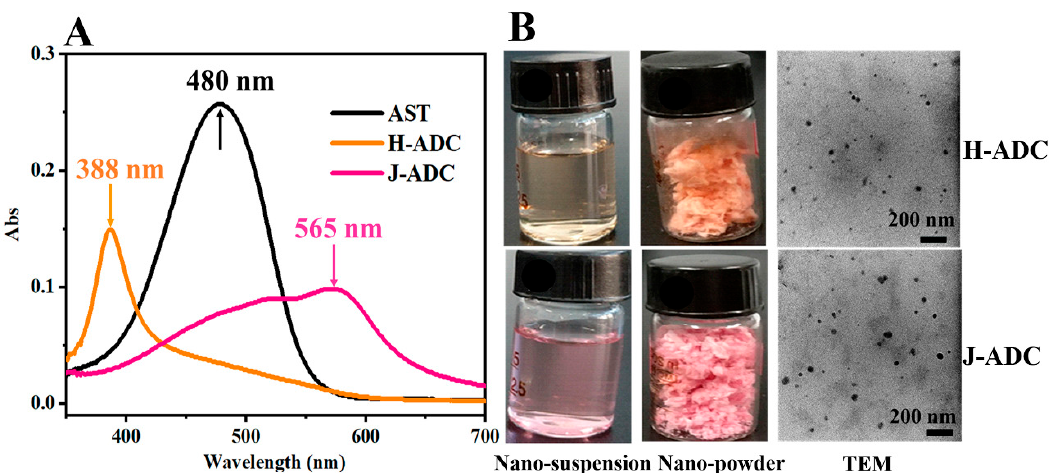
Figure 1. ( A ) Ultraviolet and visible spectrophotometry (UV-Vis) spectra of astaxanthin (AST), AST H-aggregates / DNA / chitosan nanocomplex (H-ADC) and AST J-aggregates / DNA / chitosan nanocomplex (J-ADC); ( B ) Pictures of H -ADC and J-ADC nano-suspensions, nano-powders, and their transmission electron microscopy (TEM) photos.